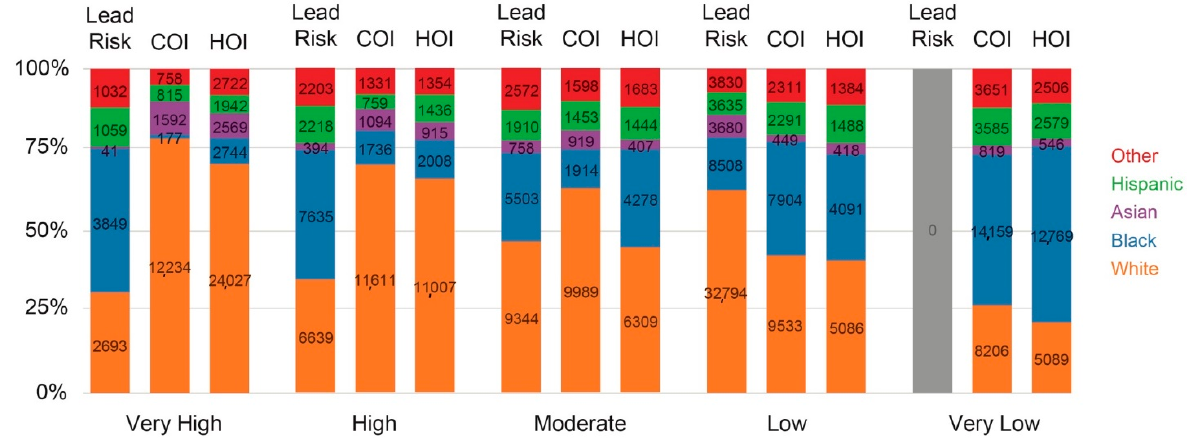
Figure 11. Lead Risk, COI, and HOI by race.